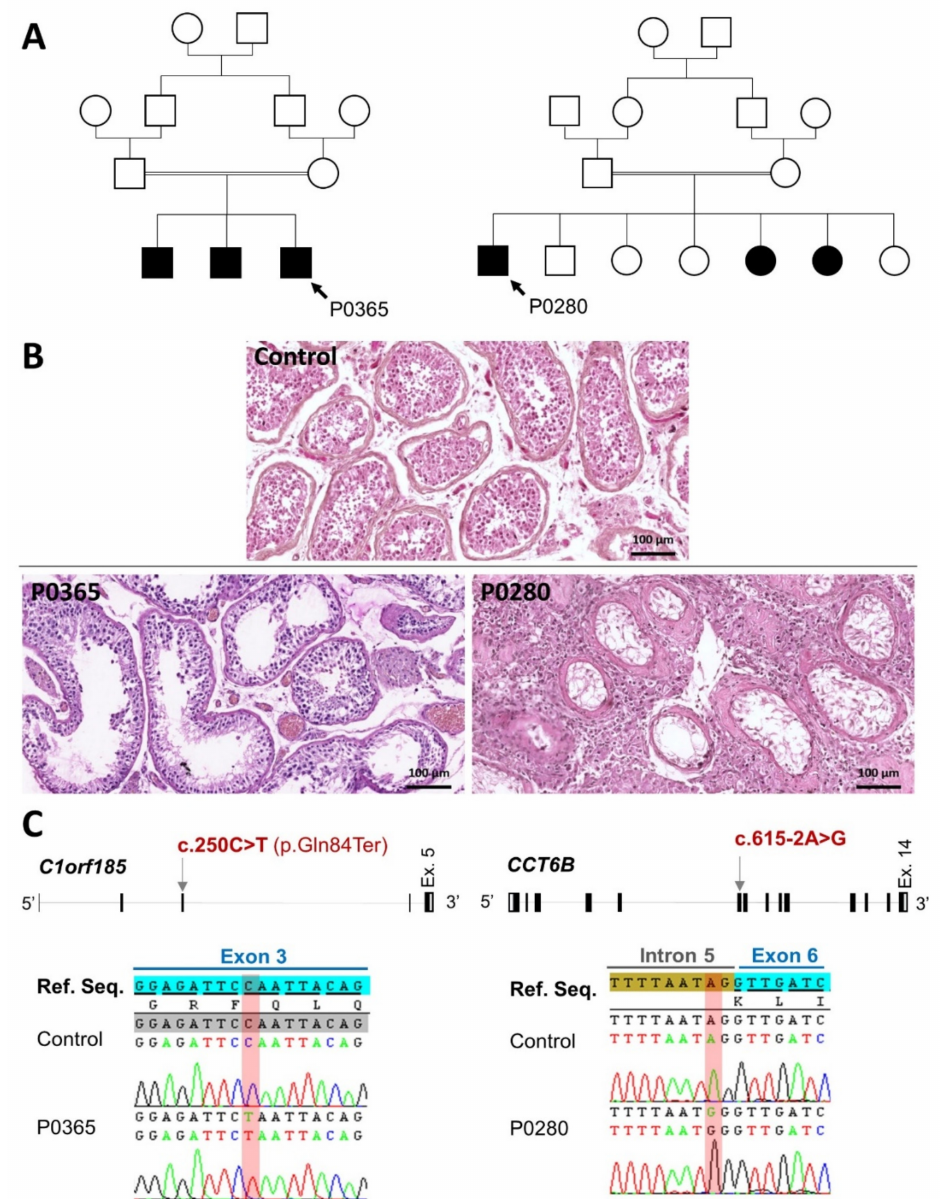
Figure 1. Genetic investigation of two idiopathic cases of non-obstructive azoospermia (NOA) and functional assessment of variant pathogenesis. ( A ) Pedigrees of the two studied subjects P0365 and P0280. Black color indicates individuals with primary infertility. ( B ) Histology of testicular seminiferous tubules obtained from the studied subjects after multifocal testicular biopsies showing a severe hypospermatogenesis in subject P0365 and a testicular degeneration in subject P0280 compared to the control (upper panel). Scale bars = 100 µ m. ( C ) Location of the identified variants in the candidate genes and the corresponding electropherograms obtained by Sanger sequencing. P0365 has a homozygous stop-gained variant in C1orf185 (c.250C>T; p.Gln84Ter) whereas P0280 carries a homozygous variant affecting a splice acceptor consensus sequence in CCT6B